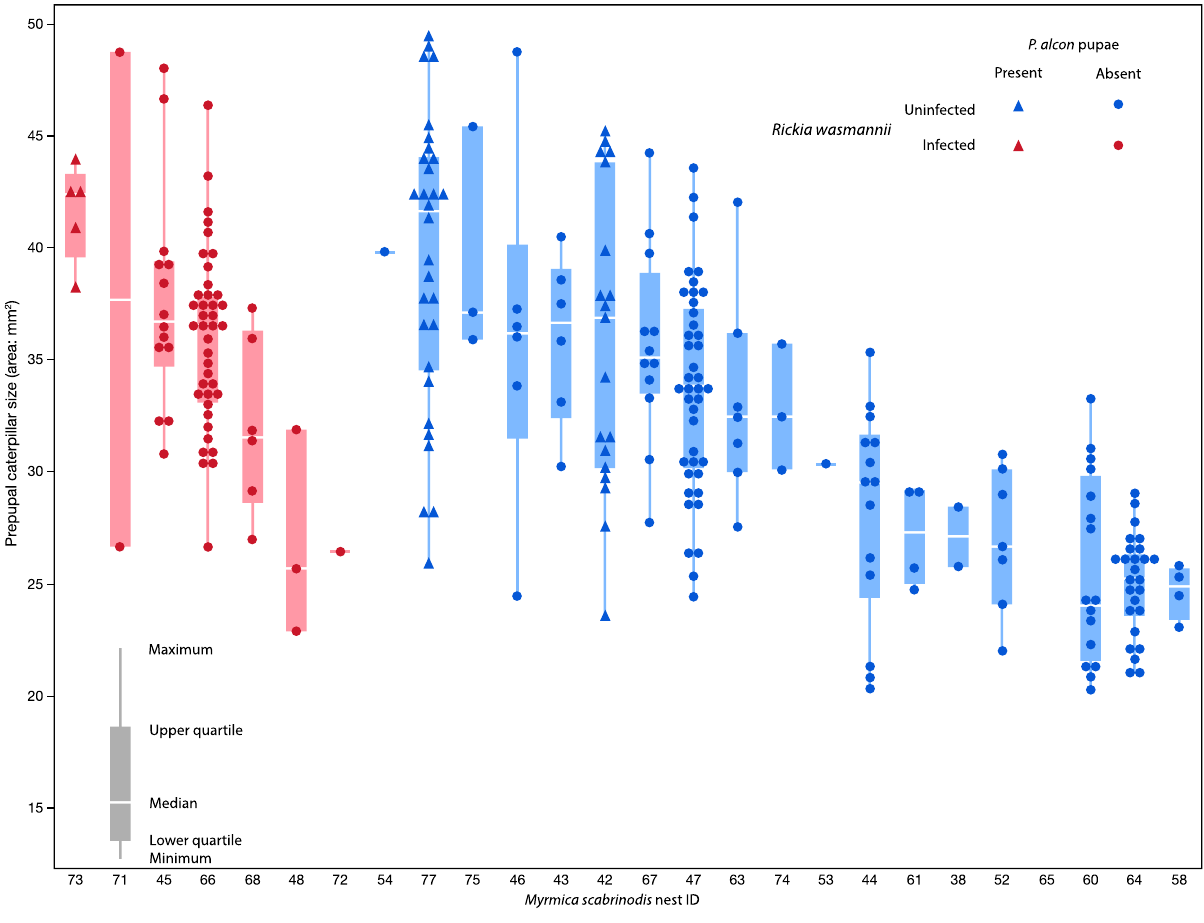
Figure 9. Box-plots with overlaid raw data showing the sizes of prepupal caterpillars of Phengaris alcon (measured as caterpillar area on field photographs) in nests of Myrmica scabrinodis with (red symbols) or without (blue symbols) Rickia wasmannii infection, and with (triangles) or without (circles) P. alcon pupae present. Nests are sorted along the x-axis by decreasing mean caterpillar size separately for infected and uninfected